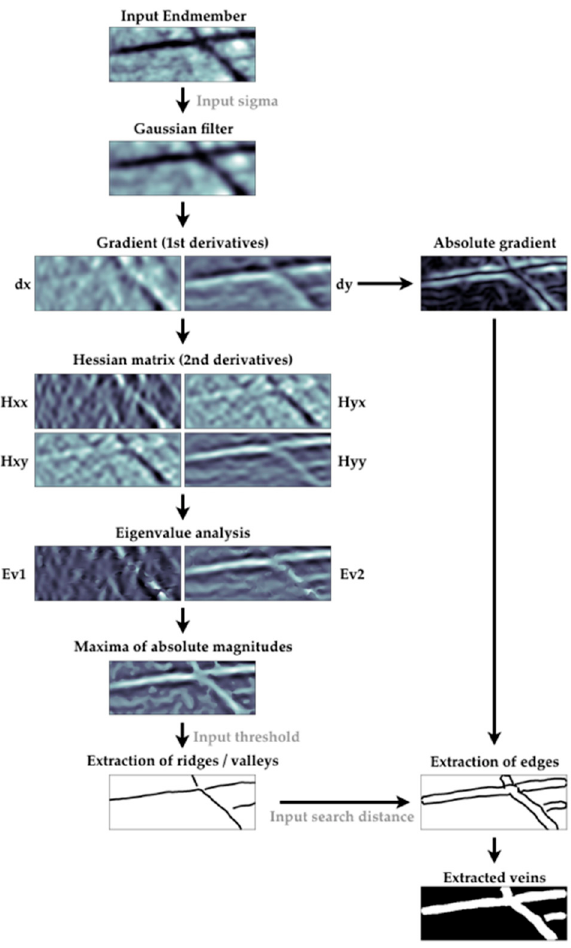
Figure 4. Proposed workflow for vein extraction.